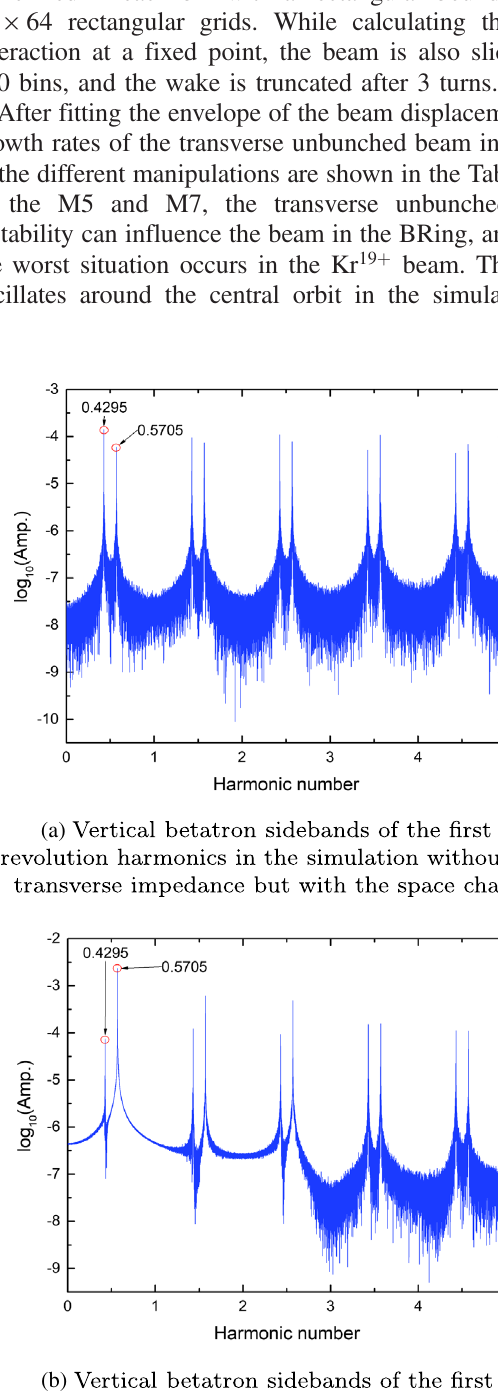
FIG. 12. Betatron sidebands in the horizontal direction. The ( 1 − Q ) line is clearly dominant and the lower betatron sidebands grow more than the upper sidebands.